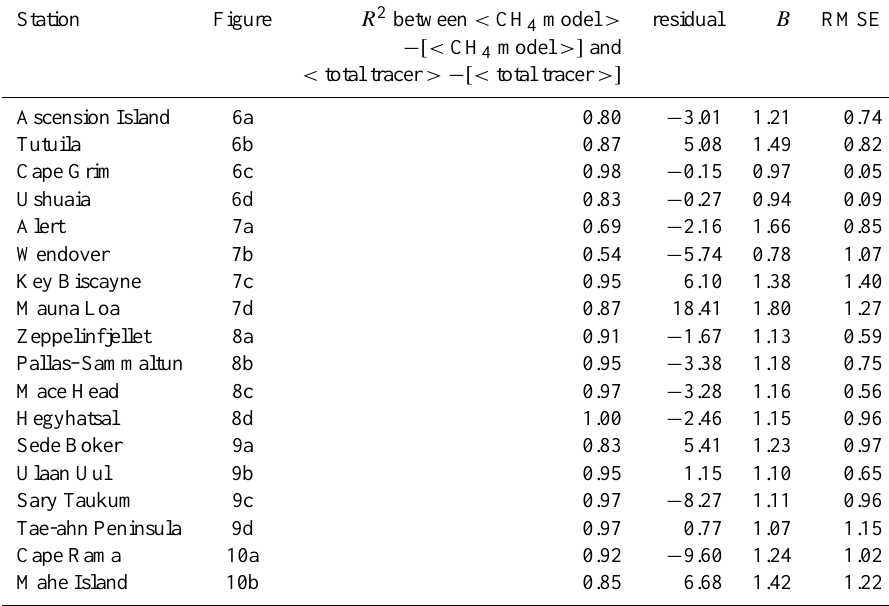
Table 2. Coefficient of determination ( R 2 ) between < CH 4 model > −[ < CH 4 model > ] and < total tracer > −[ < total tracer > ] for stations shown in Figs. 5–10. Parameters for Eq. (1) and RMSE for a linear fit between < CH 4 model > −[ < CH 4 model > ] and < total tracer > −[ < total tracer > ] . Station Figure R 2 between < CH 4 model > residual B RMSE −[ < CH ] and 4 model > < total tracer > −[ < total tracer > ] Ascension Island 6a